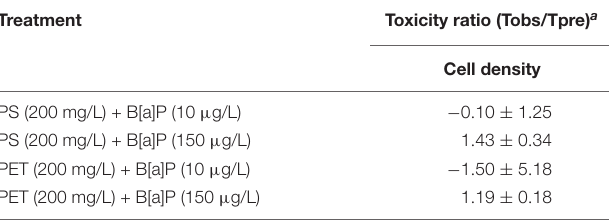
TABLE 3 | Interactive effects of microplastics and B[a]P on cell density in 15 days treated in C. muelleri. Treatment Toxicity ratio (Tobs/Tpre)